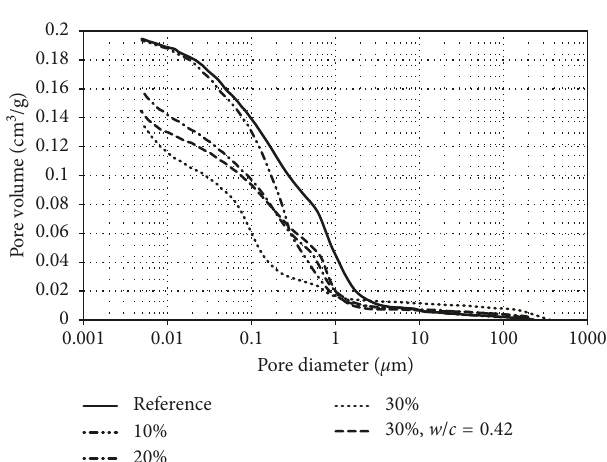
Figure 4: Cumulative pore size distribution of pastes with different ground perlite addition after 28 days of hydration.